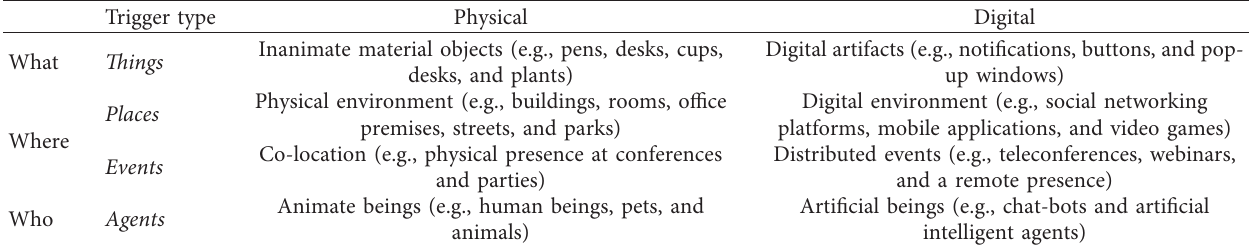
Table 1: Examples of physical and digital triggers that can initiate artificial